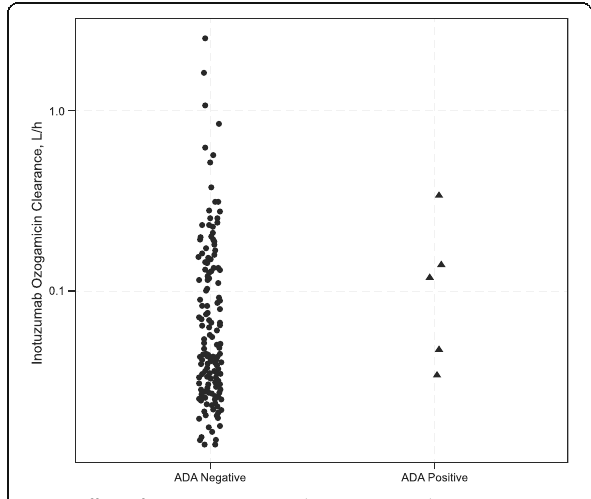
Fig. 4 Effect of ADA on inotuzumab ozogamicin clearance in patients with relapsed or refractory ALL. ADA = anti-drug antibody; ALL = acute lymphoblastic